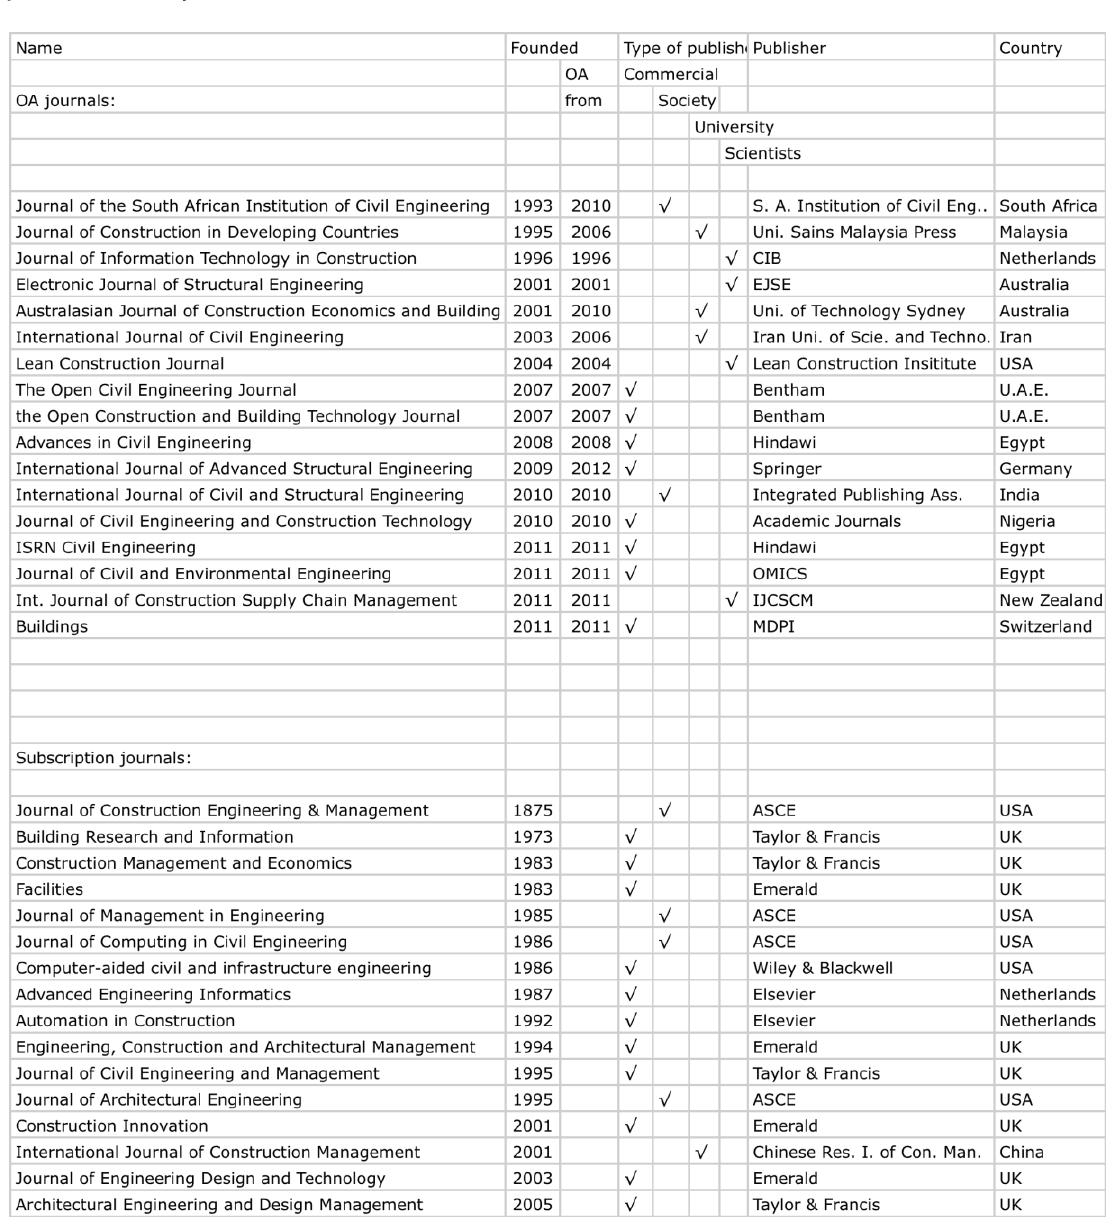
Table 1 The studied OA and subscription